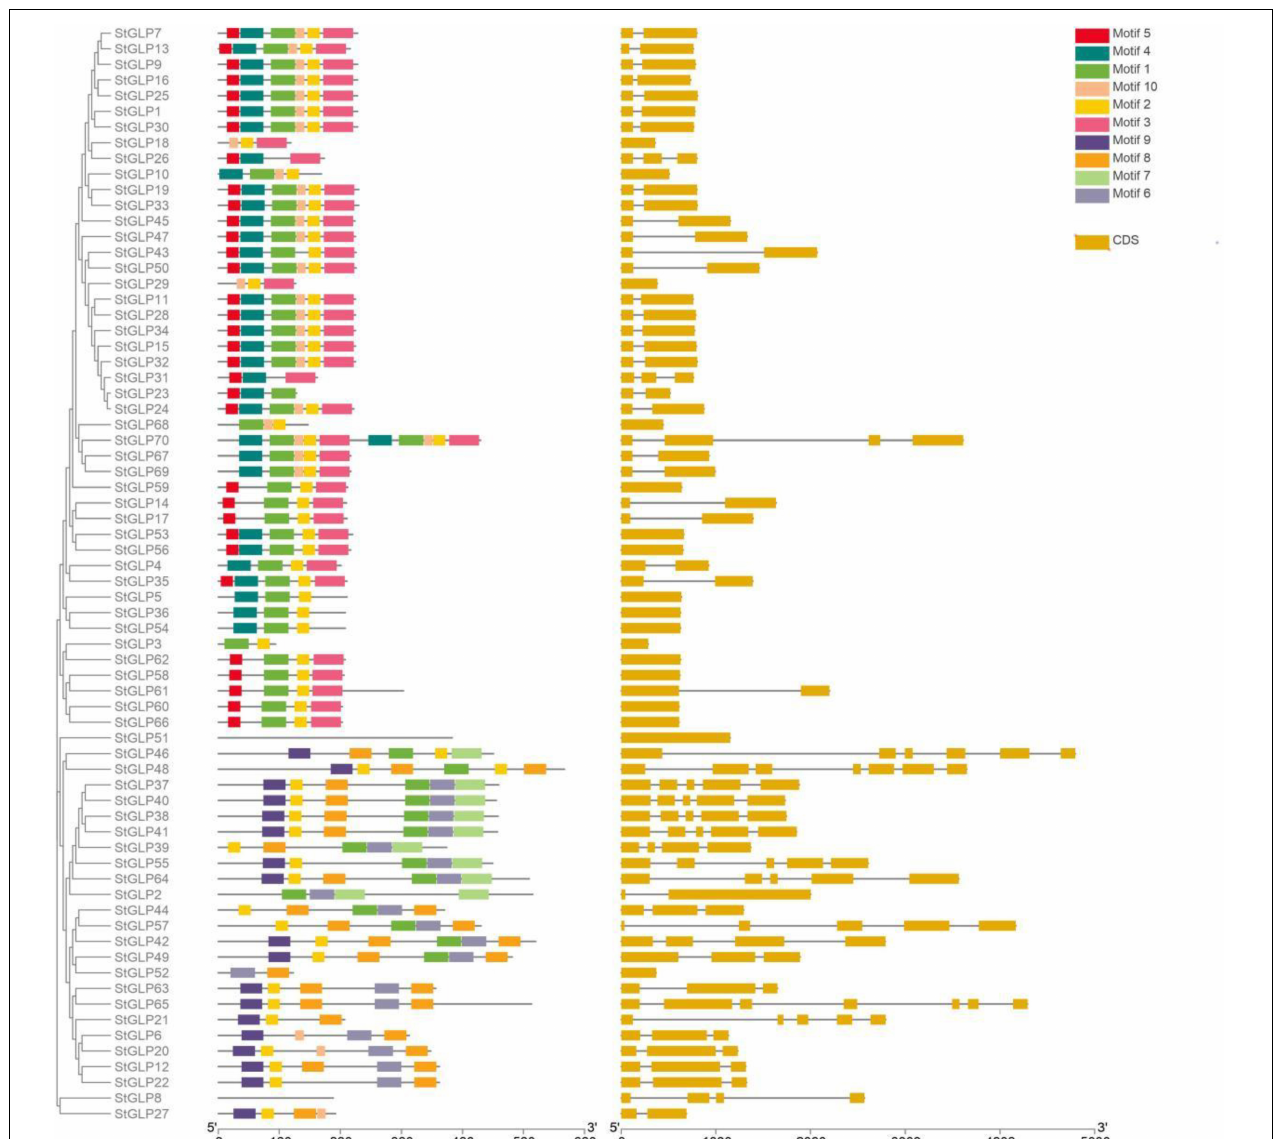
FIGURE 2 | Distribution of exons, introns, and untranslated regions (UTR) in StGLP gene sequences and distributions of de novo MEME motifs in the StGLP proteins.